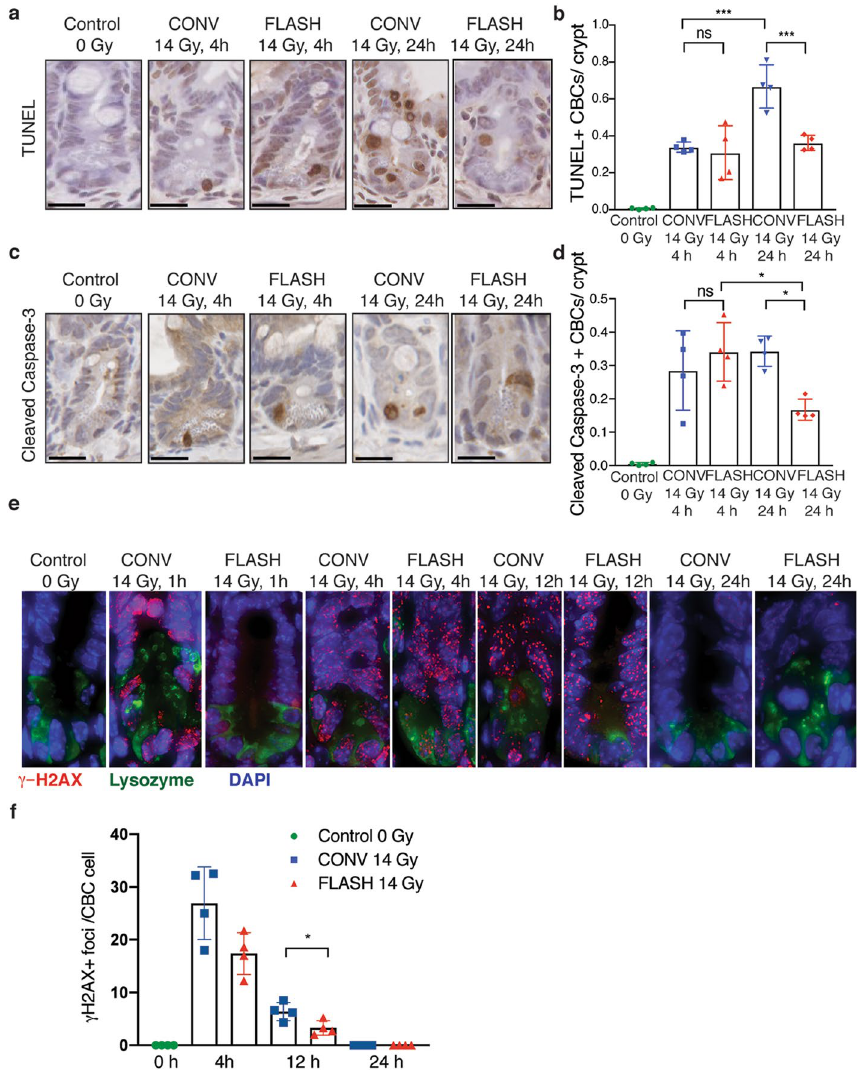
Figure 5. Abdominal FLASH irradiation produces less apoptosis and DNA damage in crypt base columnar cells (CBCs) than CONV irradiation in non-tumor bearing and tumor bearing mice. ( a ) Representative TUNEL stained images of crypts from non-tumor bearing mice at the indicated time points after sham or sublethal 14 Gy abdominal irradiation. ( b ) Quantification of the average number of TUNEL + CBCs per crypt in the jejunum at 4 and 24 h after 14 Gy abdominal irradiation. ( c ) Representative cleaved caspase-3 IHC images of crypts from non-tumor bearing mice at the indicated time points after sham or sublethal 14 Gy abdominal irradiation. ( d ) Quantification of the average number of cleaved caspase-3 + CBCs per crypt in the jejunum at 4 and 24 h after 14 Gy abdominal irradiation. CBC cells were identified based on location at the + 1 to + 3 position wedged between Paneth cells. Apoptosis in CBCs by TUNEL and cleaved caspase-3 was less at 24 h after FLASH vs . CONV irradiation. Scale bar shows 25 μm. Crypts in 3 circumferences per mouse were analyzed, n = 4 mice per group. ( e ) Representative γ-H2AX (red), lysozyme (green, a marker of Paneth cells) and DAPI (blue) stained images of crypts from ID8 ovarian tumor bearing mice at the indicated time points after sham or sublethal 14 Gy abdominal irradiation. ( f ) Quantification of the average number of γ-H2AX + foci per CBC cell located in between lysozyme + Paneth cells in the jejunum at 4 h, 12 h and 24 h after 14 Gy abdominal irradiation. n = 4 mice per group. An average of 10 CBC cells per mouse were quantified for γ-H2AX foci. At 4 and 12 h after irradiation, γ-H2AX foci in CBCs were fewer after FLASH than CONV (p < 0.05 at 12 h), and resolved in both groups by 24 h. ns no significant difference, *p < 0.05, **p < 0.01, ***p < 0.001; Unirradiated control versus CONV or FLASH compared by one-way ANOVA followed by Tukey’s multiple comparisons test. Error bars represent standard deviation of the